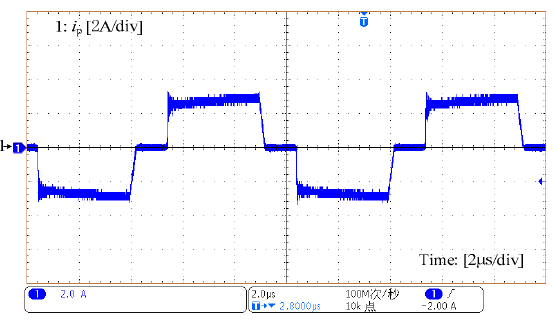
Figure 7. Waveform of i p .